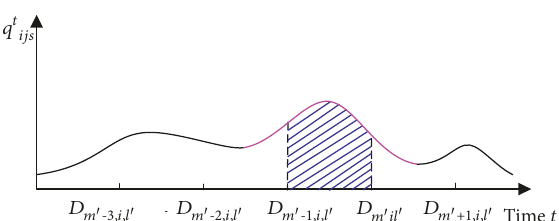
Figure 2: Temporal distribution of transfer passenger arrivals at origin station i